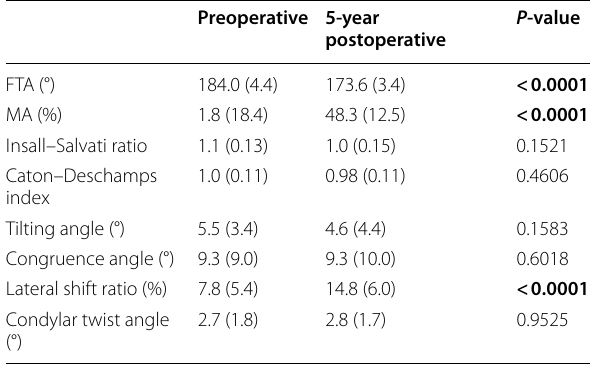
Table 4 Comparisons of preoperative and 5-year postoperative clinical and radiological outcomes